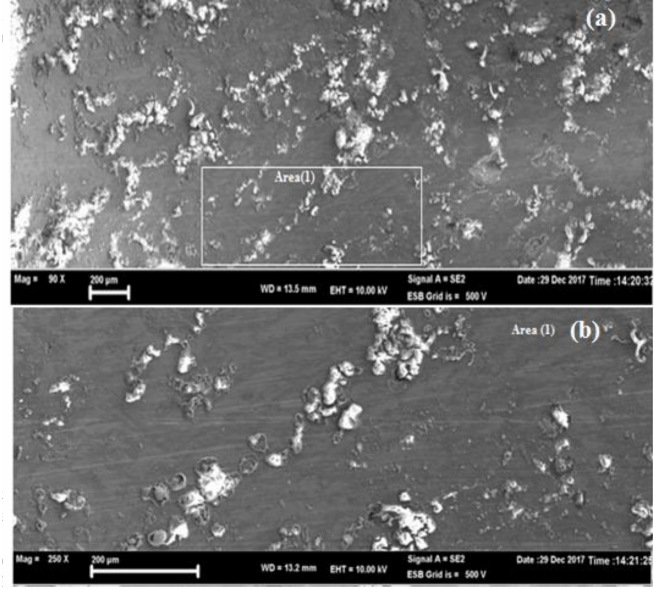
Figure 13. ( a ) SEM image of the drilled surface at Vc = 50 m/min and f = 0.10 mm/rev when using the uncoated drill bit; and ( b ) SEM image of selected area 1 with 250 ×